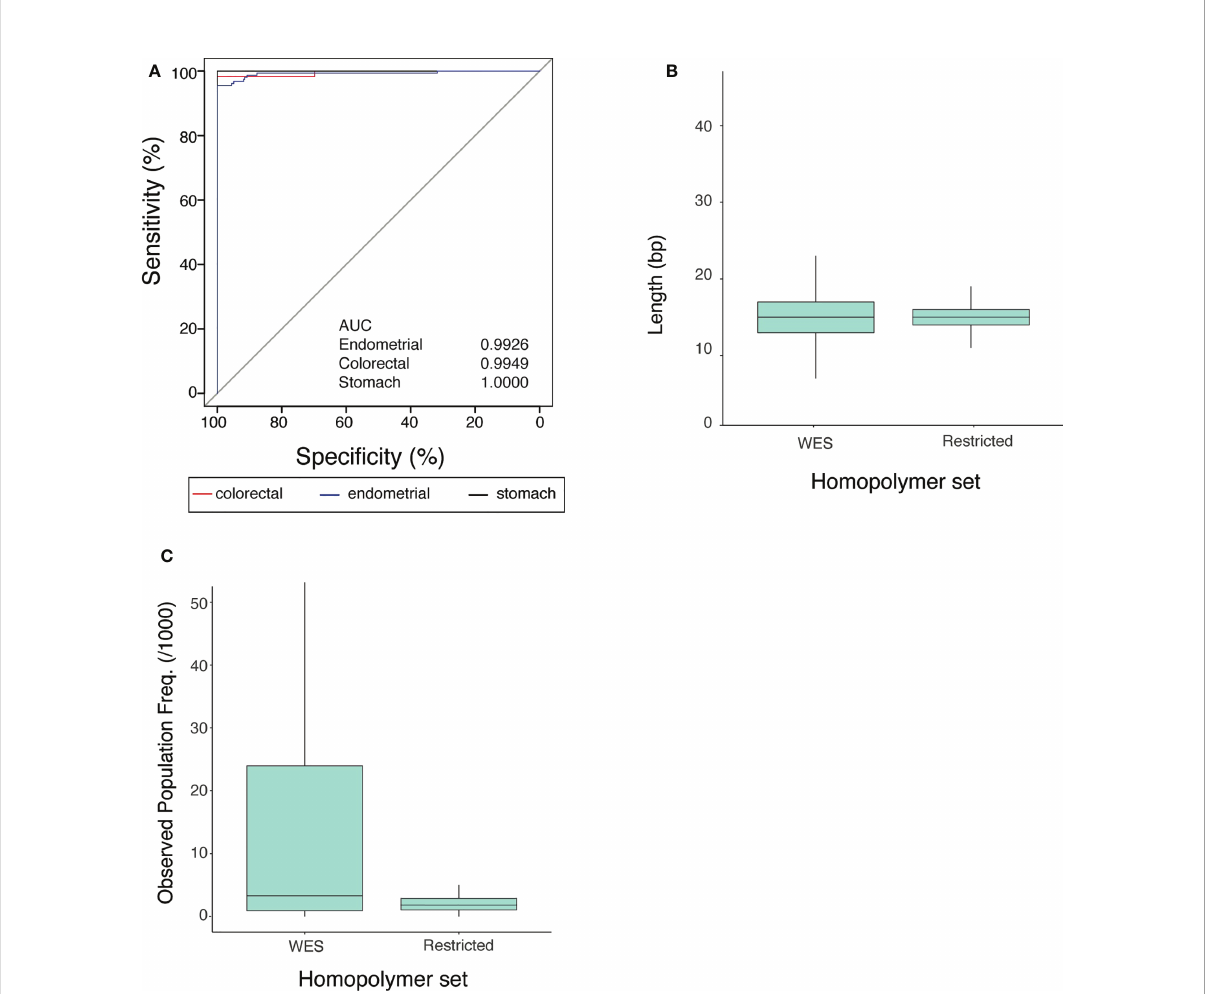
FIGURE 2 Properties of the MSIdetect restricted homopolymer set (A) Receiver Operating curves and corresponding Area Under the Curve (AUC) values (in the inset) for endometrial (blue), colorectal (red) and stomach (black) cancers for MSI classi fi cation by MSIdetect using WES homopolymers given the MSI status reported by TCGA. (B) Homopolymer length distribution in WES and in the restricted set. (C) Distribution of average variant population frequency observed in gnomAD for homopolymers in WES and in the restricted set with lengths ranging from 11-25